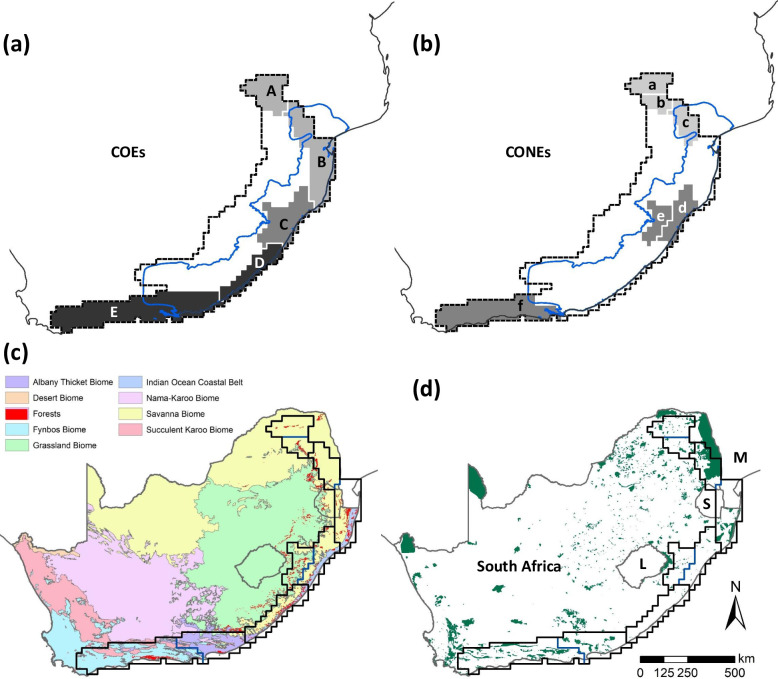
Centres of endemism (COEs) and centres of narrow endemism (CONEs) for land snails of south-eastern Africa derived from the phenetic cluster dendrogram (Fig 2A).Centres are shaded on a grey scale based on number of endemics, given below for each in brackets (darker shades denote high endemism). See Table 3 for lists of endemic species. (a) COEs: A–Sky islands (4), B–Extended Maputaland (4), C–Natal (6), D—Extended Pondoland (7), and E—Albany-Knysna (7). (b) CONEs: a—Soutpansberg (2), b—Wolkberg (2), c—Northern Middleveld (2), d—Natal coastal belt-Ngoye (3), e—Natal Midlands, and f—Knysna (3). The whole (blue) line indicates the Maputaland-Pondoland-Albany (MPA) hotspot boundary while the dashed (black) line delimits the greater MPA region of land snail endemism. COEs and CONEs are spatially compared with (c) South African biomes and (d) the protected area network of South Africa (SA); protected areas in Lesotho (L), Swaziland (S) and Mozambique (M) are not included. The MPA hotspot boundary, biomes and protected areas of SA are reprinted from Hoffman et al. [26], Open Knowledge Foundation [67] and the Department of Environmental Affairs, Forestry and Fisheries [68] (public domain), respectively.